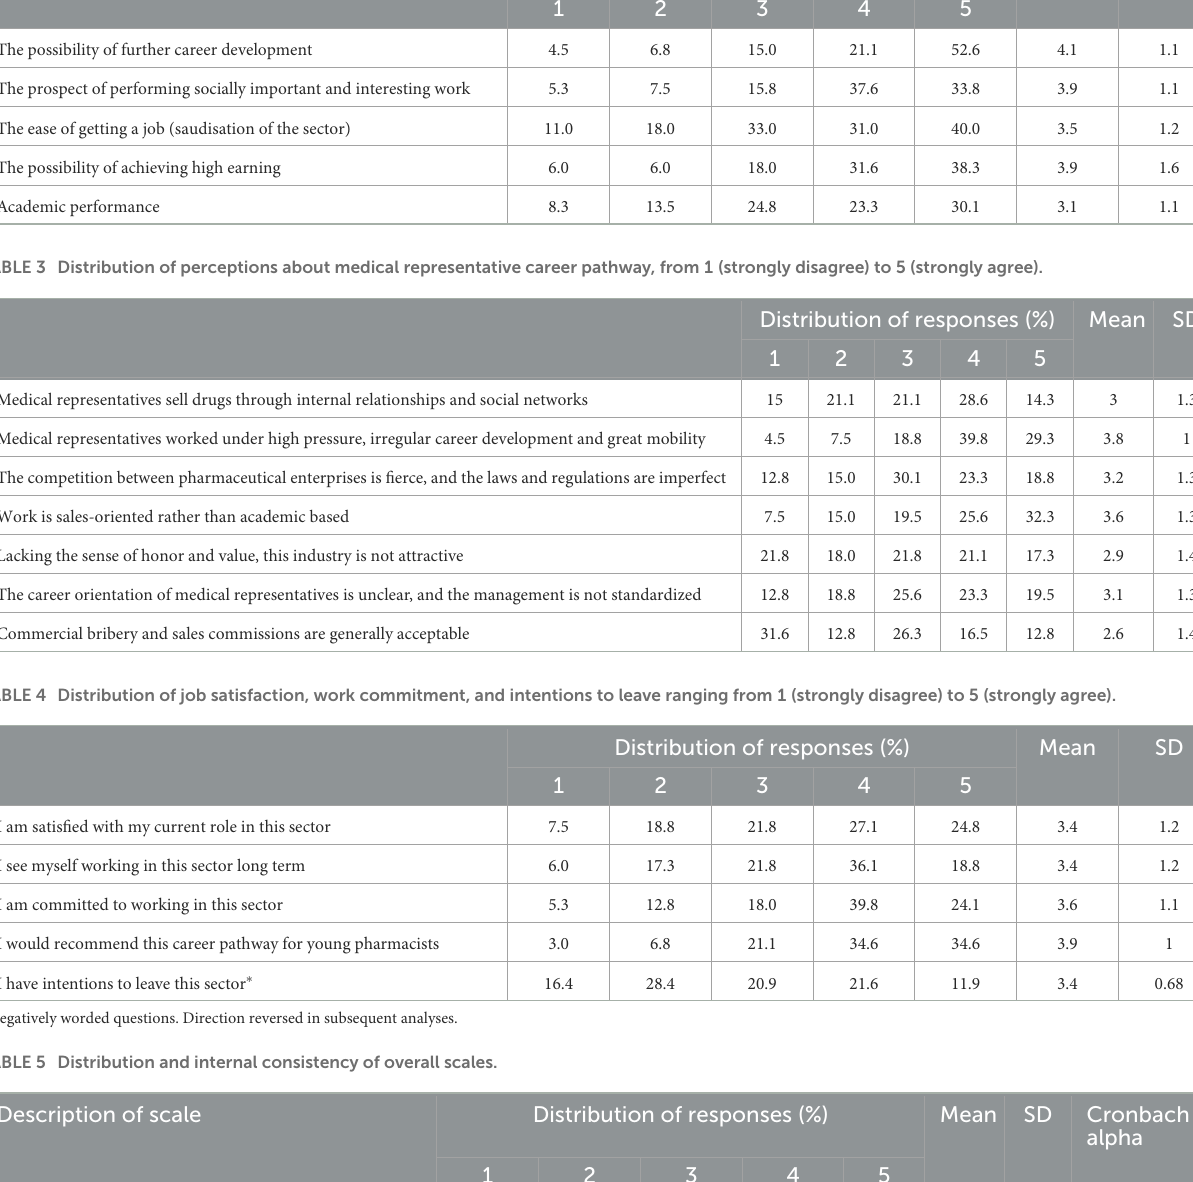
TABLE 2 Distribution of contributing factors for choosing to work as a medical representative, ranging from 1 (very unimportant) to 5 (very important). Distribution of responses (%)